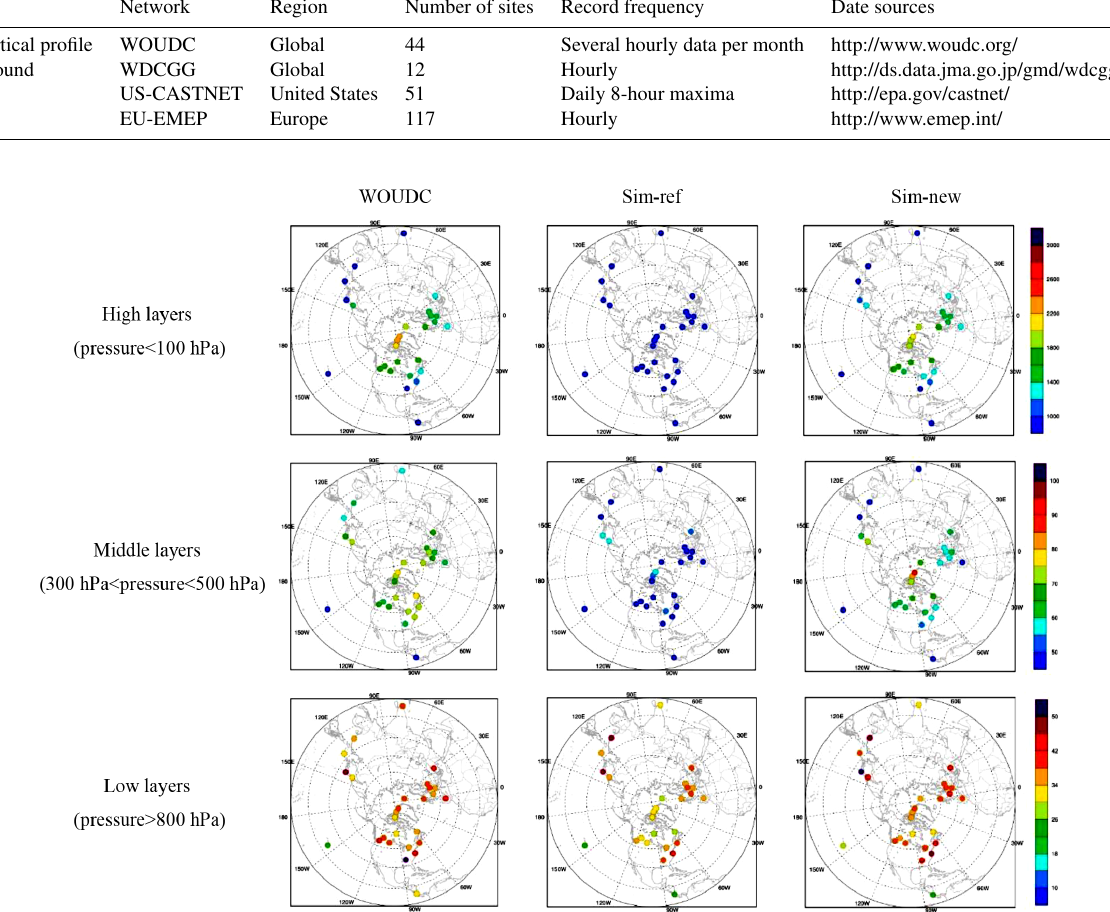
Figure 4. Ozone spatial distributions (annual mean of measurement time period for each WOUDC site, ppb, January–December